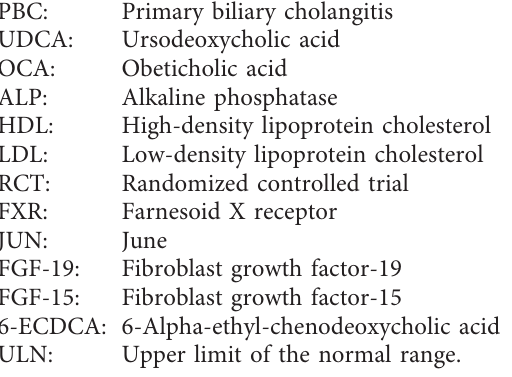
Supplementary 1. Electronic search strategy for PubMed database. Supplementary Figure S1. (a) Effect on the bio- chemical response in patients with PBC treated with